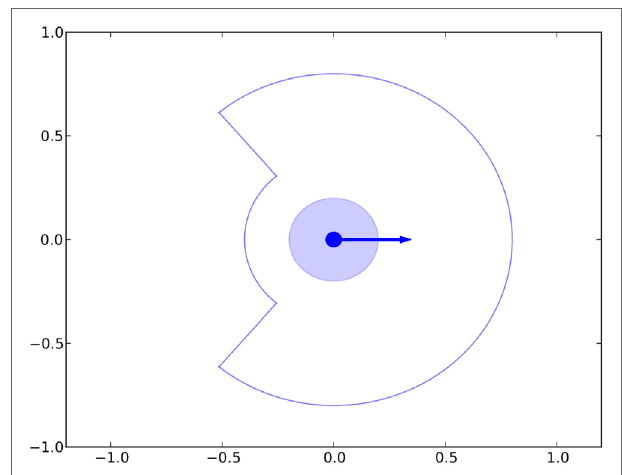
FigUre 7 | The area of attention used by the CE is indicated by a solid line. Also shown is the area defined by the safety radius as the lightly blue shaded